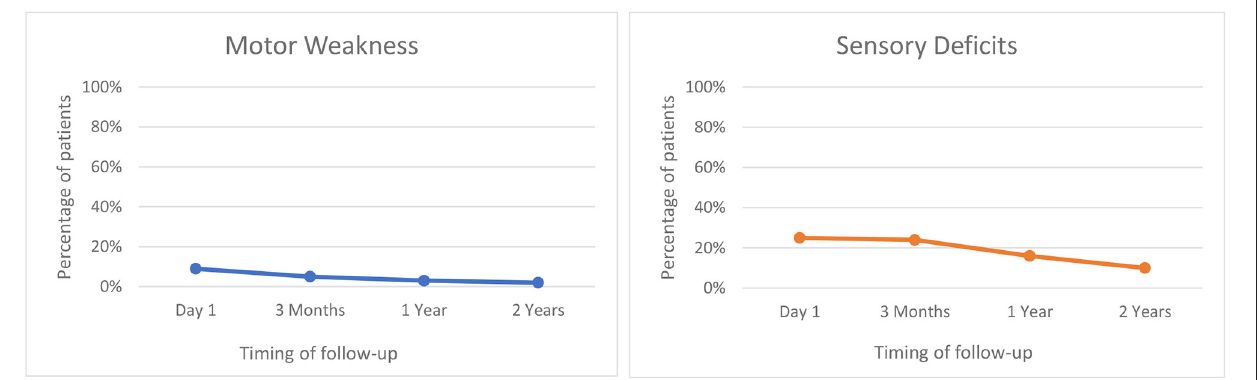
FIGURE 3 | Evolution of adverse events following MRgFUS thalamotomy.